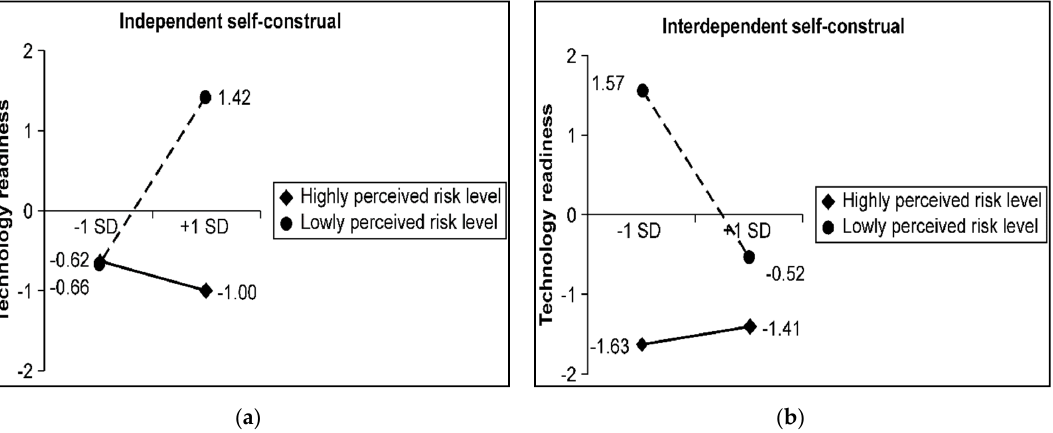
Figure 1. Technology readiness: ( a ) technology readiness toward the mobile app as a function of participants’ independent self-construal and perceived risk; ( b ) technology readiness toward the mobile app as a function of participants’ interdependent self-construal and perceived risk; SD is standard deviation.